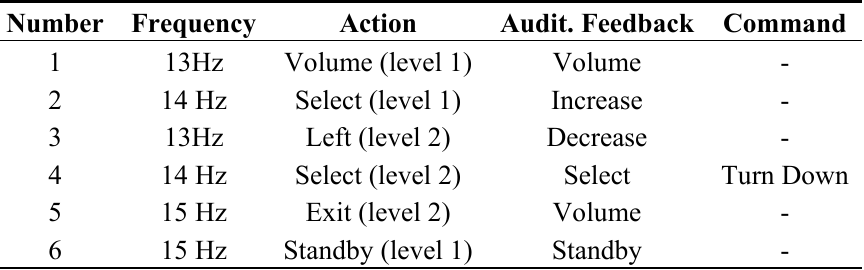
Table 2. Turn down the volume on the